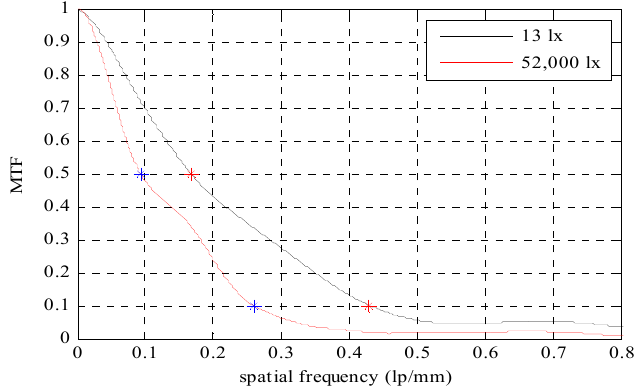
Figure 11. Response of the modulation transfer function (MTF) acquired at the boundary line of the crack image at the 5m object distance using edge method.